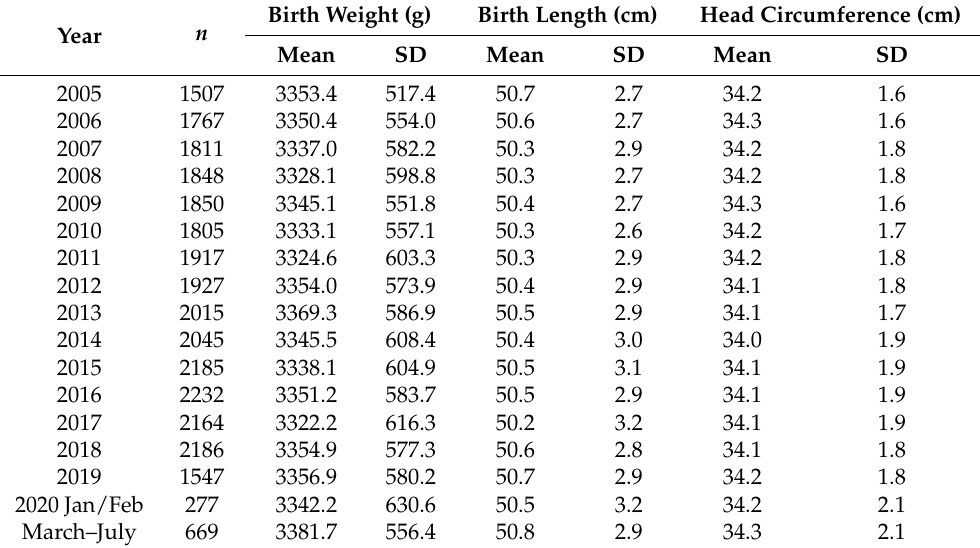
Table 3. Newborn parameters birthweight, birth length and head circumference 2005 to 2020 descrip- tive